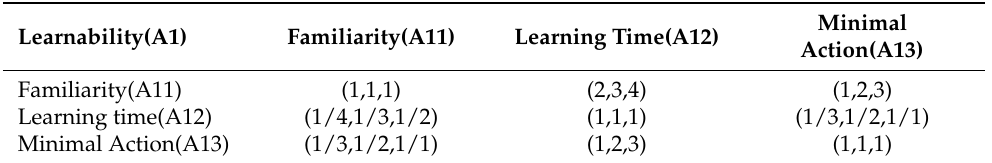
Table 5. Fuzzy-based comparison matrix associated with the sub-criteria in relation to the learnability (A1) criteria.